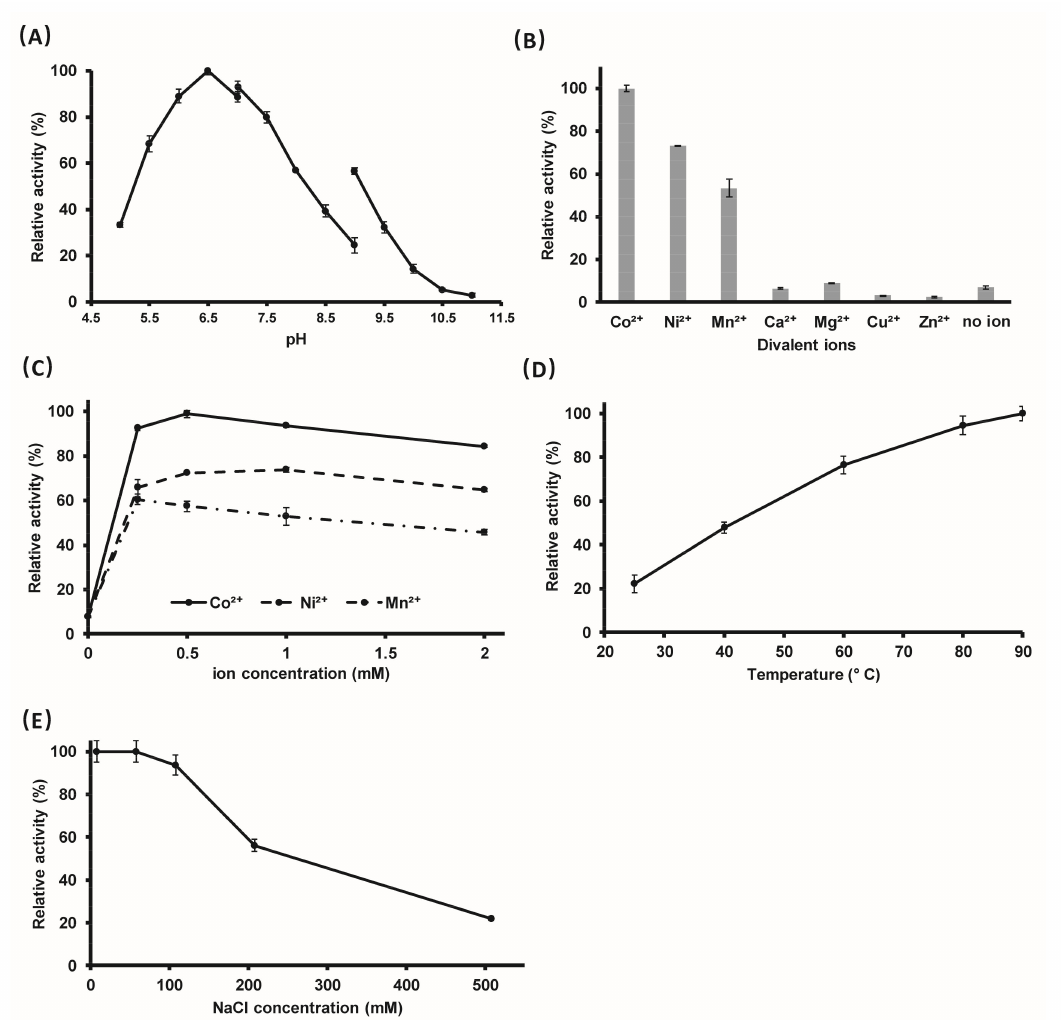
Figure 3. Effect of pH ( A ), divalent metal ions ( B ), divalent metal ion concentrations ( C ), NaCl concentrations ( D ), and reaction temperature ( E ) on the activity of PyapApase. Each reaction contains 0.2 mM of pApase and 3.75 nM of pAp. ( A ) pH-dependent reactions were run with the following buffers (each at 20 mM): MES-NaOH (pH 5–7), Tris-HCl (pH 7–9), and Gly-NaOH (pH 9–11). ( B ) Divalent metal ions were present at a concentration of 1 mM. ( C ) Divalent metal ion (Ni 2+ , Co 2+ , Mn 2+ ) dependence over a concentration range of 0 to 2 mM. ( D ) NaCl concentration over a range of 15 to 500 mM. ( E ) Temperature dependence over a range of 25 to 90 ◦ C. Activities are expressed as percentages of the best condition for each parameter: pH 6.5 ( A ), Co 2+ ( B ), 0.5 mM Co 2+ ( C ), 50 mM NaCl ( D ), and 90 ◦ C ( E